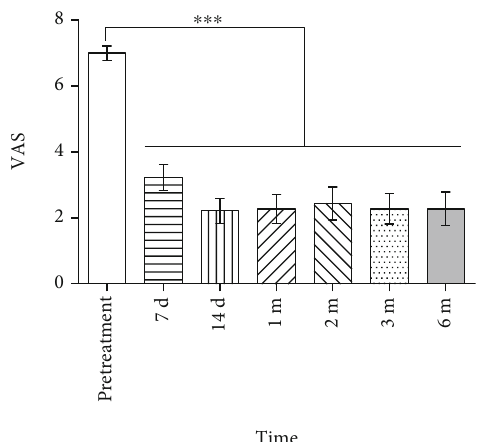
Figure 5: Results of the visual analogue scale (VAS) before and after high-voltage long-duration pulsed radiofrequency (PRF) treatment. VAS signi fi cantly decreased on 7d after treatment and remained steady till 6 months. There was no signi fi cant di ff erence among all the time points after treatment (pretreatment vs. 7d, 14d, 1 m, 2 m, 3 m, and 6m posttreatment; ∗∗∗ P < 0 : 001